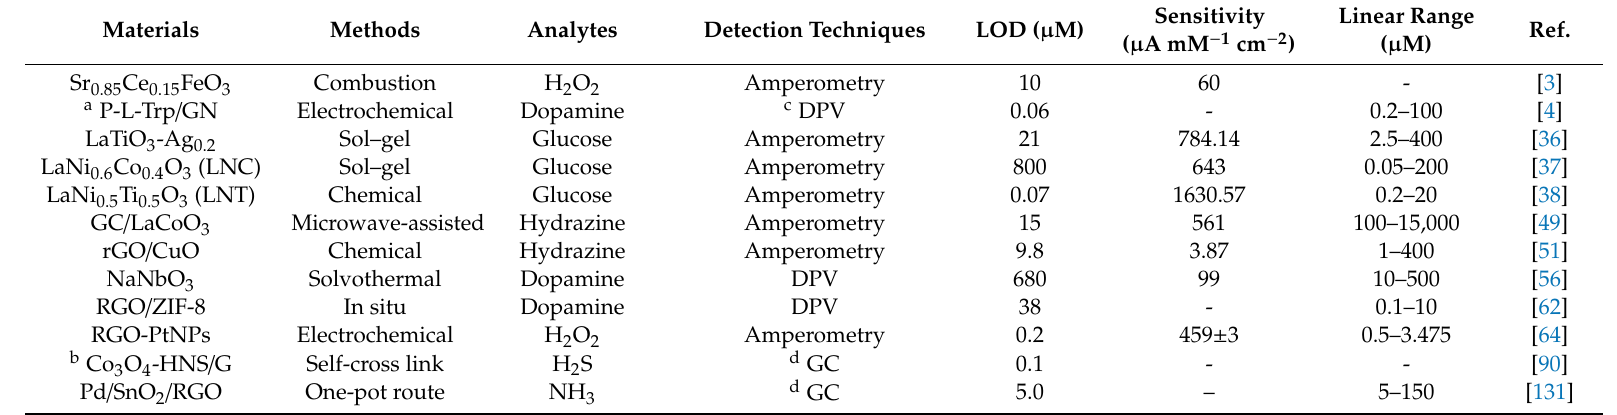
Table 1. Comparison of the analytical performances based on graphene and perovskite composite and the previously reported sensing